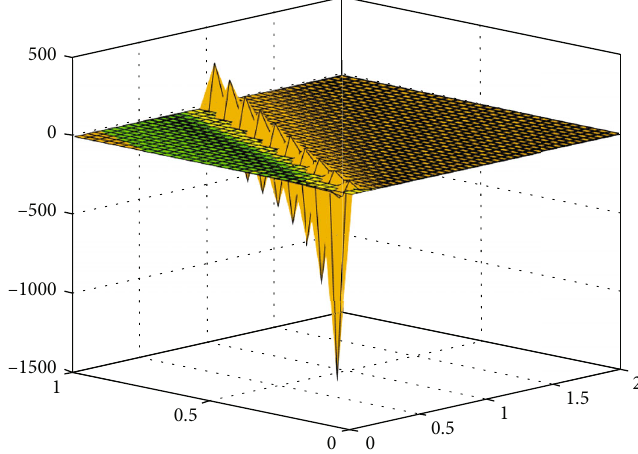
Figure 2: Three-dimensional illustration of the error and error bounds for